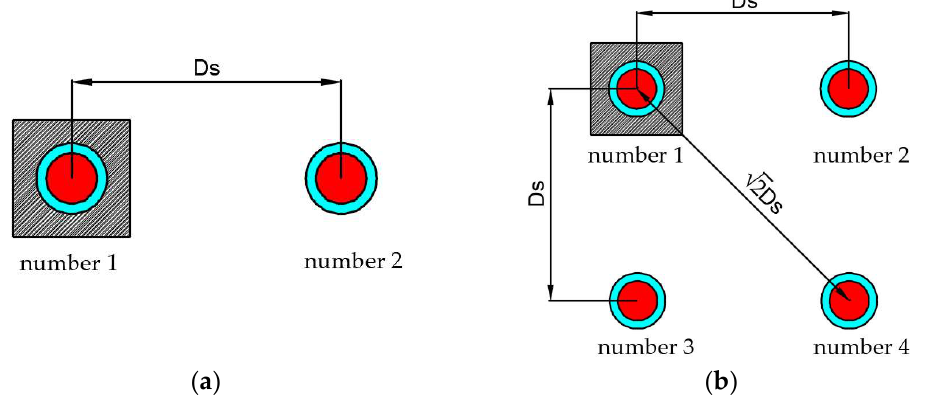
Figure 2. Schematic diagram of the arrangement of porous heat exchangers. ( a ) Double boreholes. ( b ) Four boreholes.